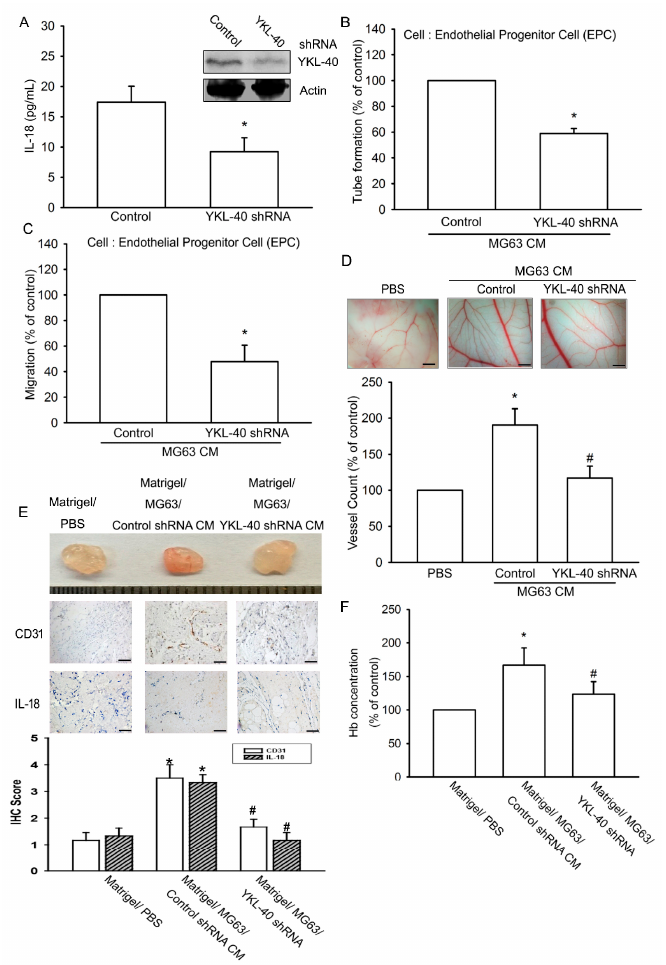
Figure 6. YKL-40 inhibition reduces angiogenesis in vivo. ( A ) MG-63 cells were infected with control or YKL-40 shRNA, then IL-18 and YKL-40 expression were examined by Western blotting and ELISA ( n = 5 per group). ( B , C ) CM was collected and applied to EPCs. Capillary-like structure formation and cell migration of EPCs was examined by tube formation and Transwell assay ( n = 4 per group). ( D ) CM was also applied for 3-day- to 5-day-old fertilized chick embryos. CAMs were then examined by microscopy and photographed. Angiogenesis was quantified by counting the number of blood vessel branches ( n = 5 per group). Scale bar = 2 mm. ( E , F ) Matrigel plugs containing CM were subcutaneously injected into the flanks of BALB/c male nude mice. After 7 days, the plugs were photographed and hemoglobin levels were quantified by the Drabkin method. Specimens from the plugs were immunostained with antibodies against CD31 and IL-18. Quantification results are shown in the lower panel ( n = 5 per group). Scale bar = 20 µ m. Results are expressed as the mean ± S.E. * p < 0.05 compared with control. # p < 0.05 compared with the YKL-40-treated group.